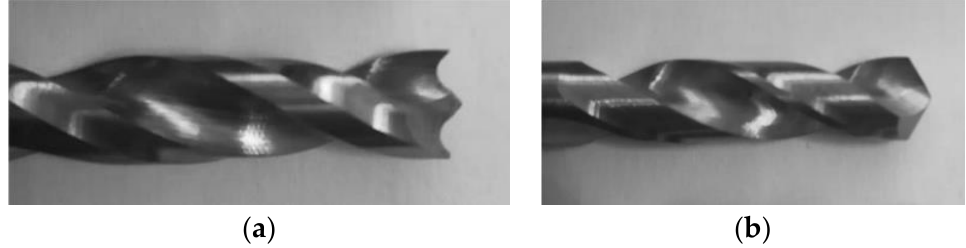
Figure 2. Drill geometries considered in experimental work: ( a ) Brad; ( b ) Twist.